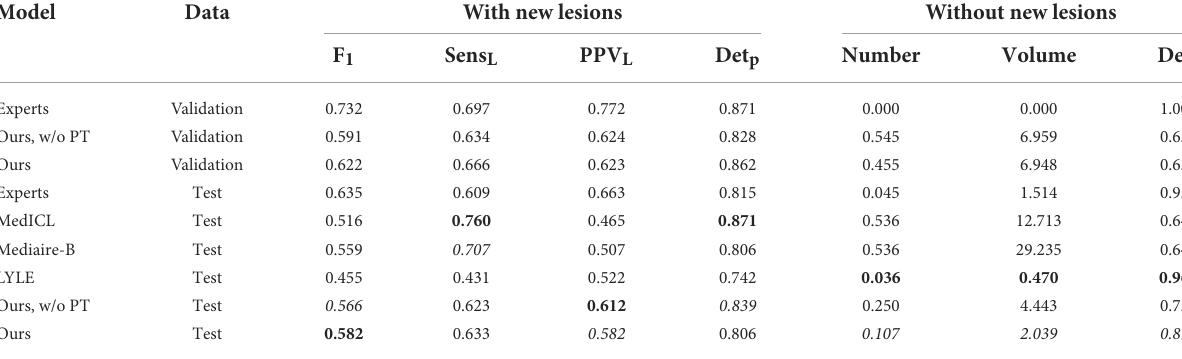
TABLE 1 New lesion detection results for images with and without new lesions in ground